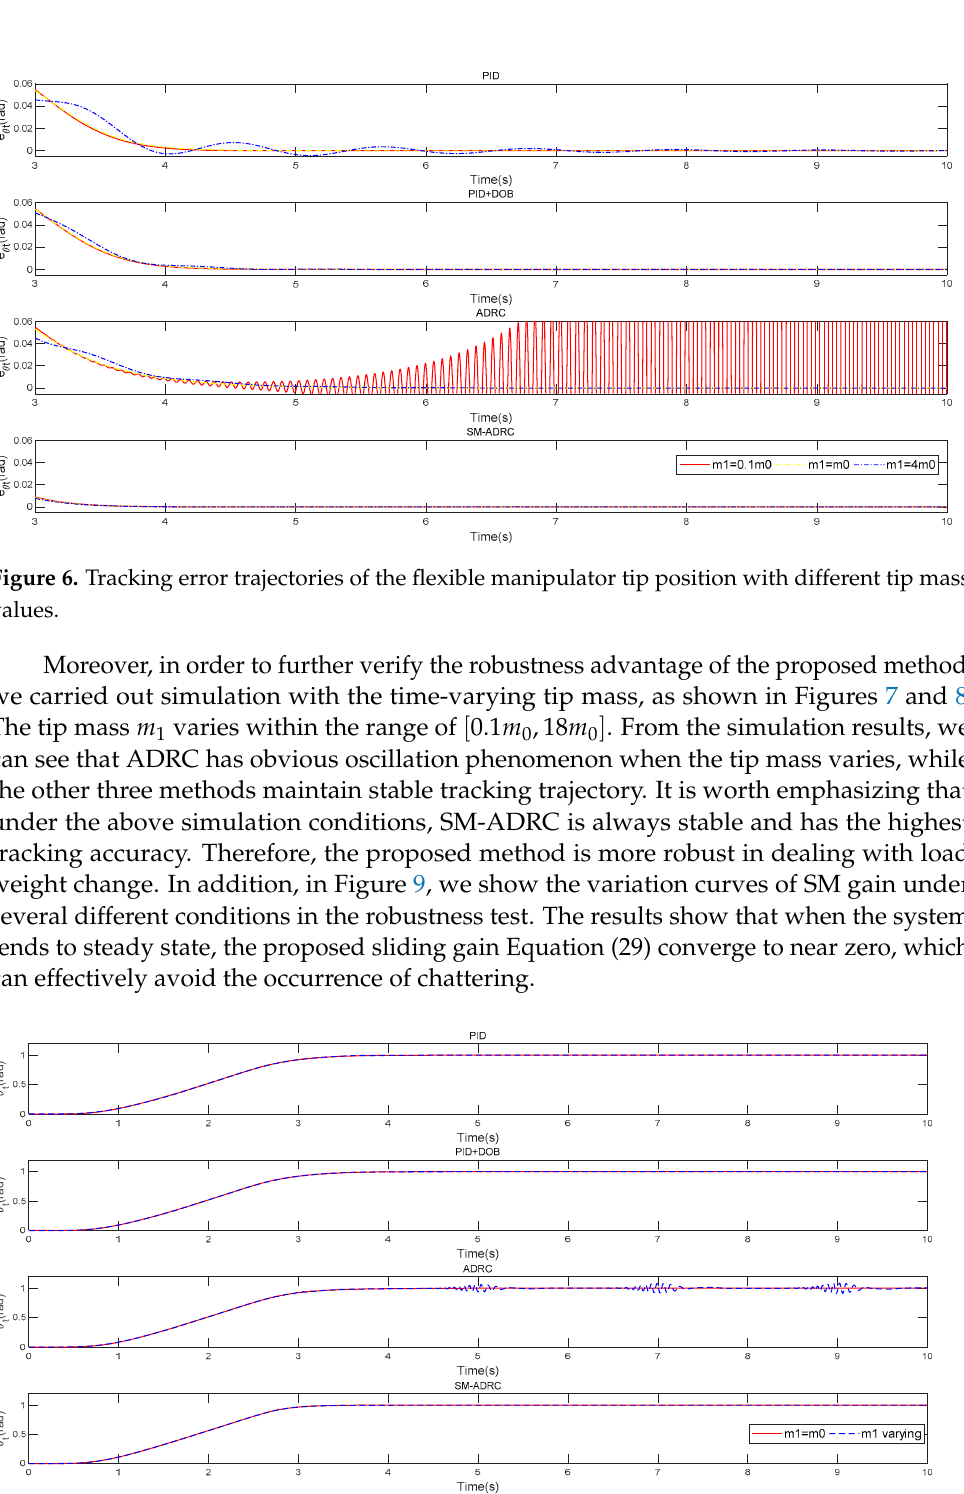
Figure 5. Tracking trajectories of the flexible manipulator tip position with different tip mass values.